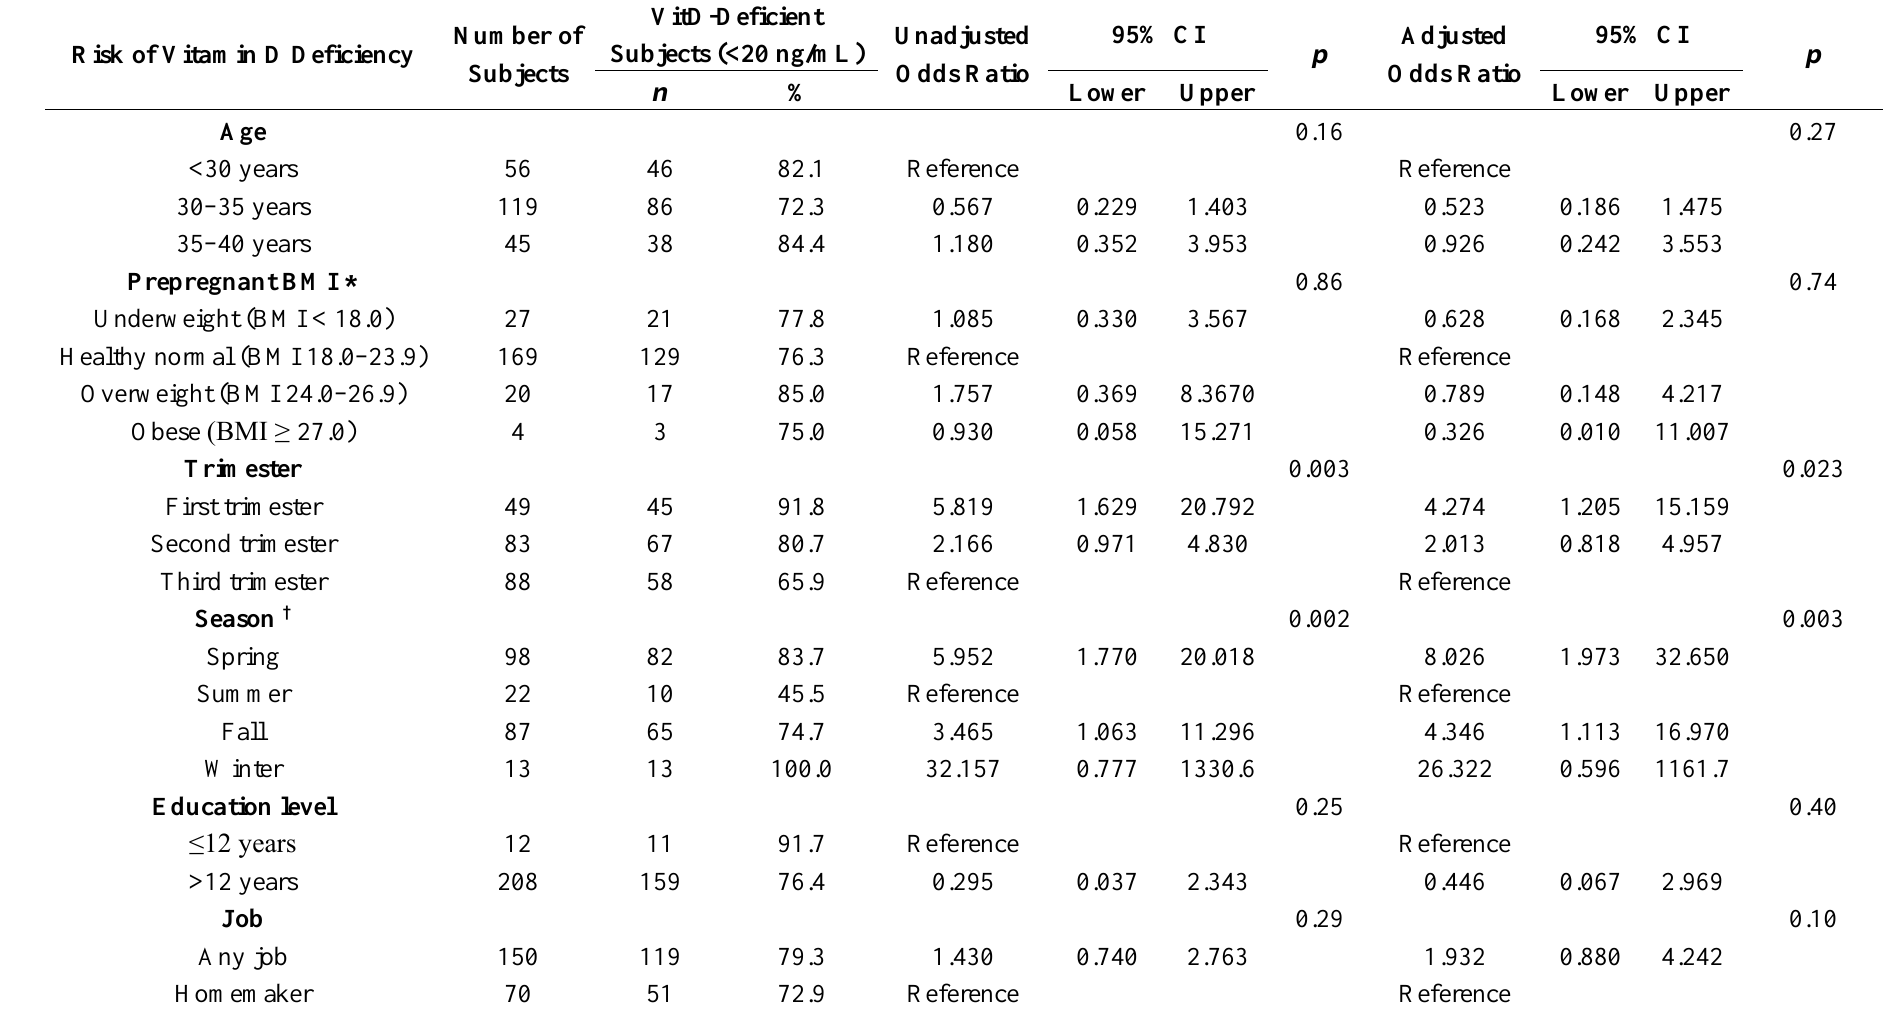
Table 4. Risk of vitamin D deficiency during pregnancy in 220 Korean